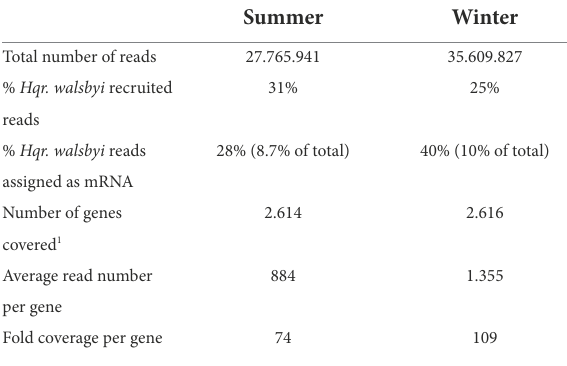
TABLE 1 General statistics of the winter and summer metatranscriptomes and reads recruited to Hqr. walsbyi